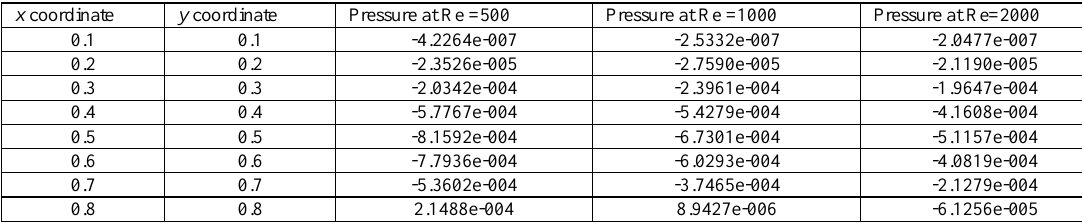
Table 3. Pressure at different nodes and different values of Re at t